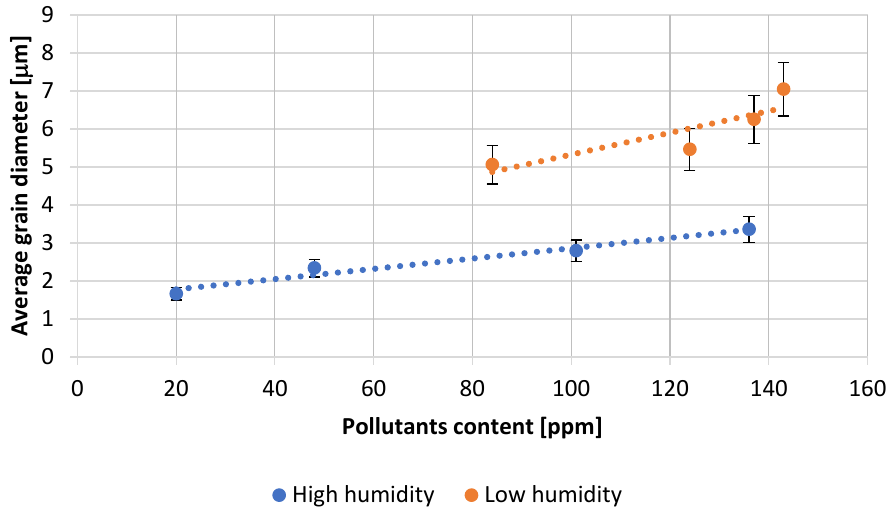
Figure 14. Dependence of average grain diameter of PbO on pollutants content.